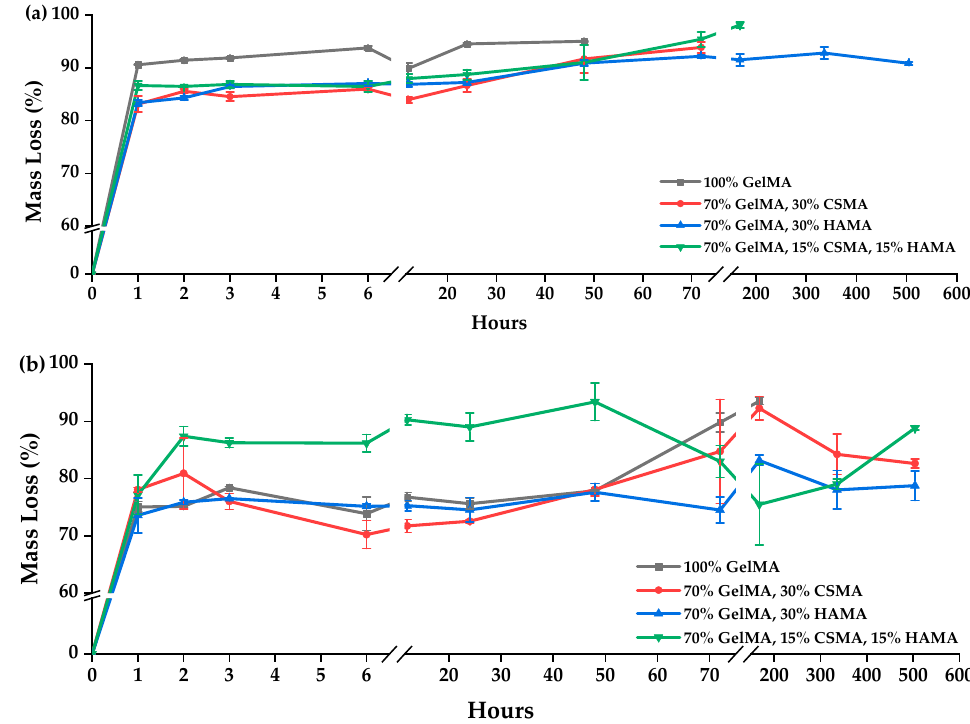
Figure 7. Mass Loss ratio (%) of hydrogels produced with ( a ) 10% ( w / v ) GelMA solution or; ( b ) 20% ( w / v ) GelMA solution, upon incubation in PBS with collagenase.